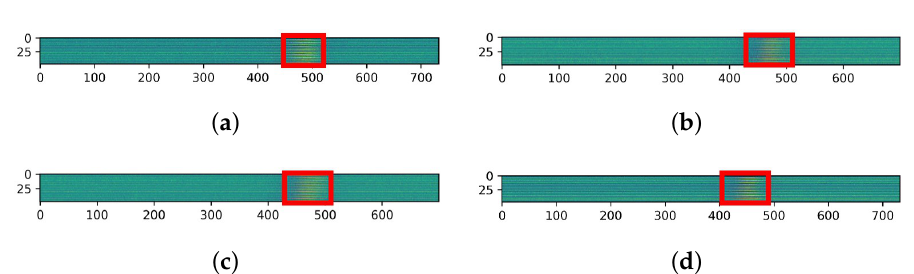
Figure 8. CNN input data samples. ( a ) is CNN sample array data 1 and ( b ) is CNN sample array data 2, ( c ) is CNN array image data 3, ( d ) is CNN array image data